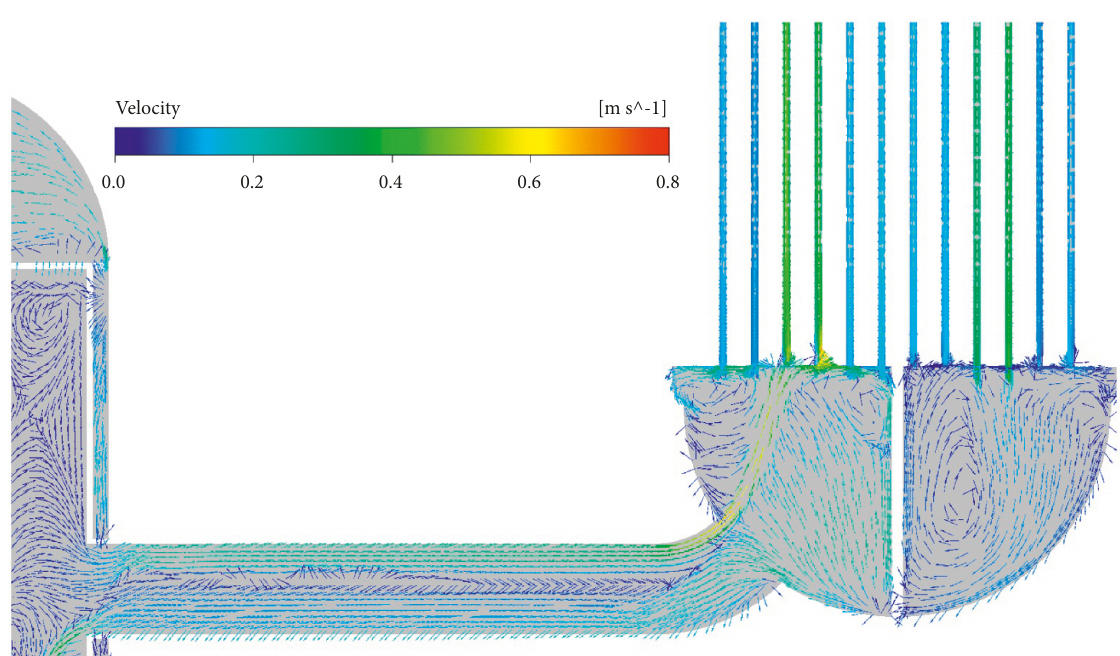
Figure 6: Velocity vector on symmetry plane (model 1).